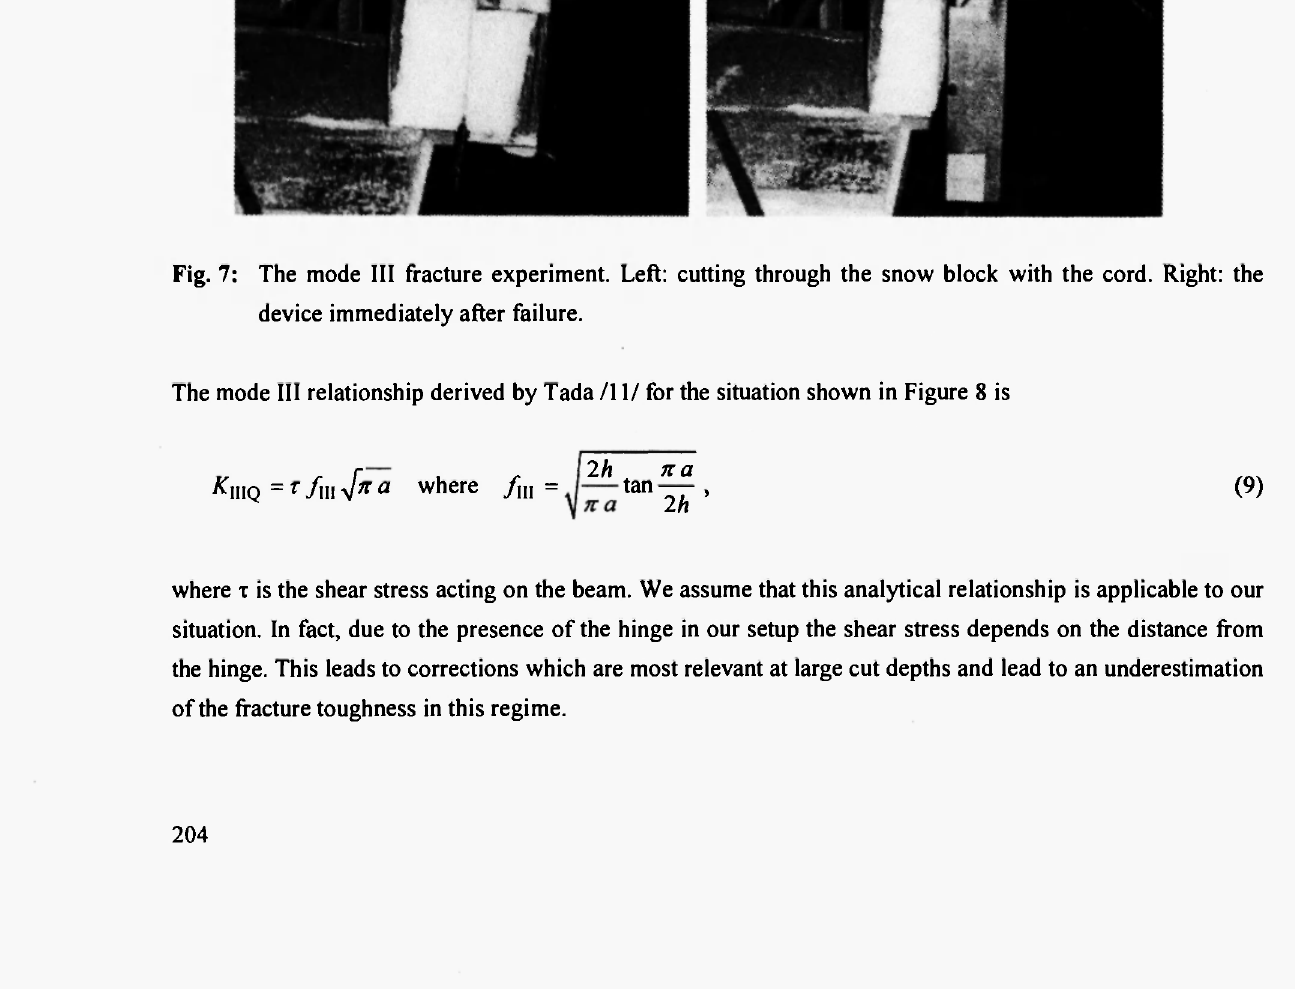
Fig. 6: Illustration of the device used for mode III fracture testing of snow.